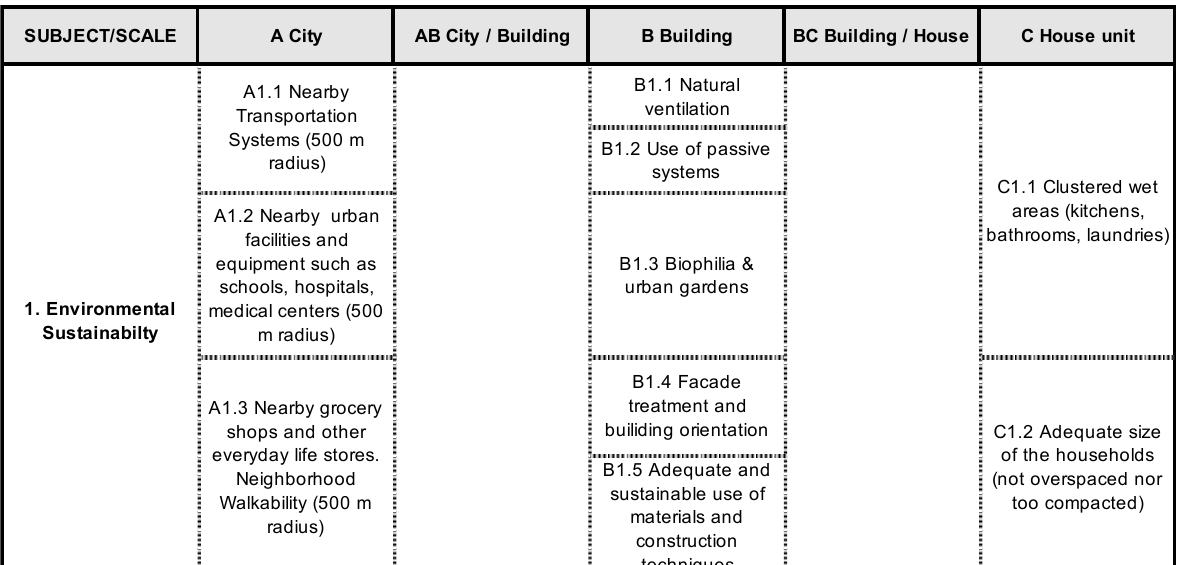
Figure 1. Environmental Sustainability Indicators. Source own elaboration.